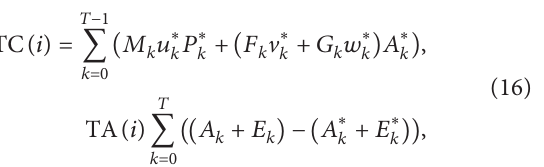
v w k , k , and k . (a) The optimal control